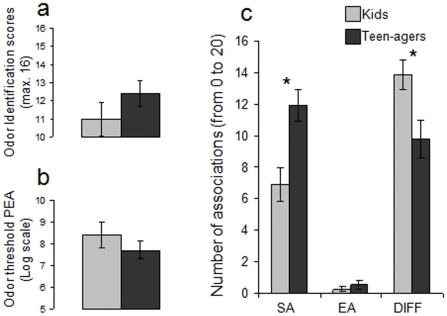
Experiment 2.Kids and teen-agers did not differ in odor identification (a) and odor threshold (b). Teen-agers supplied more semantic associations (SA) and had less difficulty in supplying any associations (DIFF) than kids (c). * significant difference at the 5% statistical significance threshold.